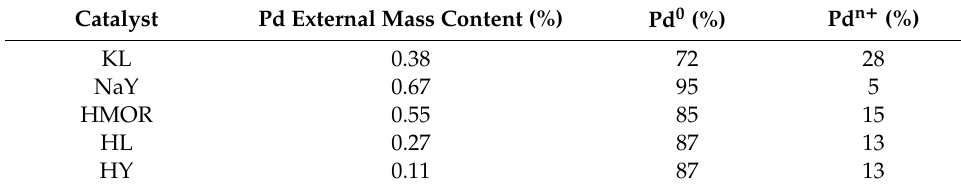
Figure 5. Desorbed NH 3 versus Pd mean particle size. Table 3. Pd external mass content, Pd 0 and Pd n+ obtained from XPS.